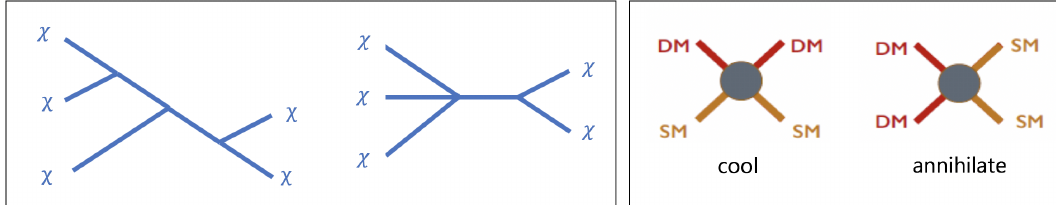
scalar model. Right: 3